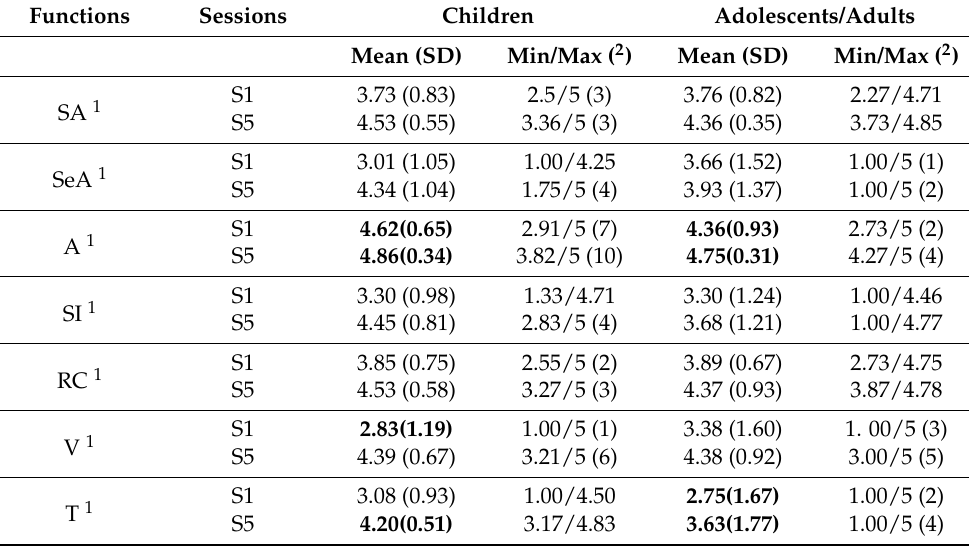
Table 1. Children’s and adolescents’/adults’ performances in S1 and